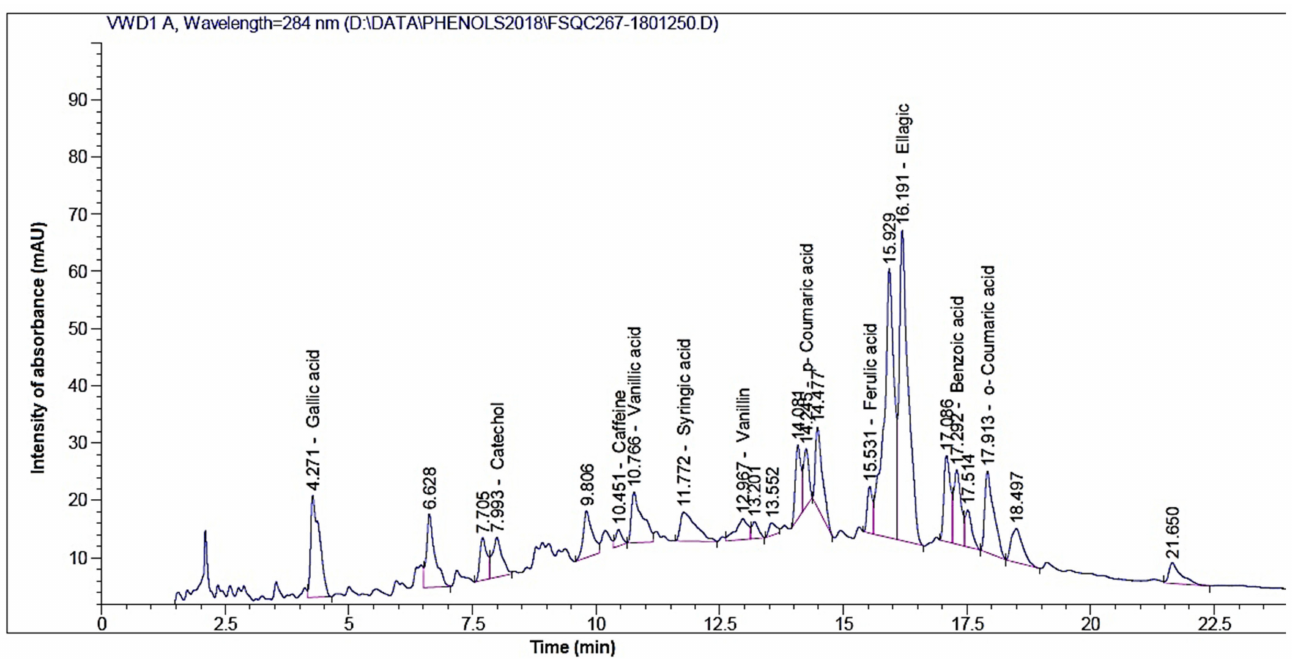
Figure 1. High Performance Liquid Chromatography (HPLC) chromatogram of phenolic compounds present in clove